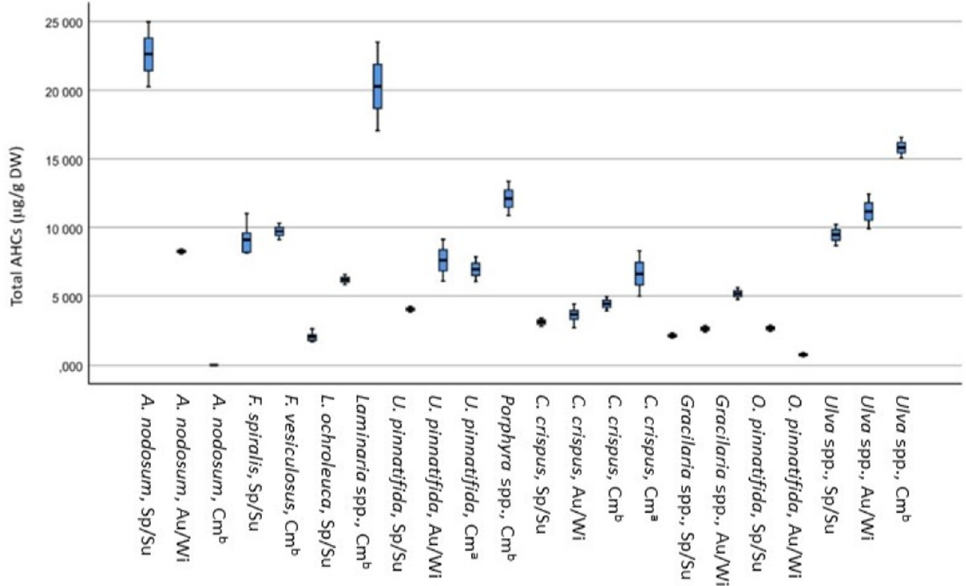
Figure 1. Box plots showing the Total AHCs content (ug/g DW) in different seaweeds species. Sp: Spring; Su: Summer; Au; Autumn; Wi: Winter; Cm a : Commercial wild origin; Cm b : Commercial aquaculture origin. The total AHCs content varied between 11 and 32 µ g/g DW in A. nodosum , 2.8 and 13 µ g/g DW in C. crispus , 11 and 13 µ g/g DW in Fucus spp., 3.6 and 7.0 µ g/g DW